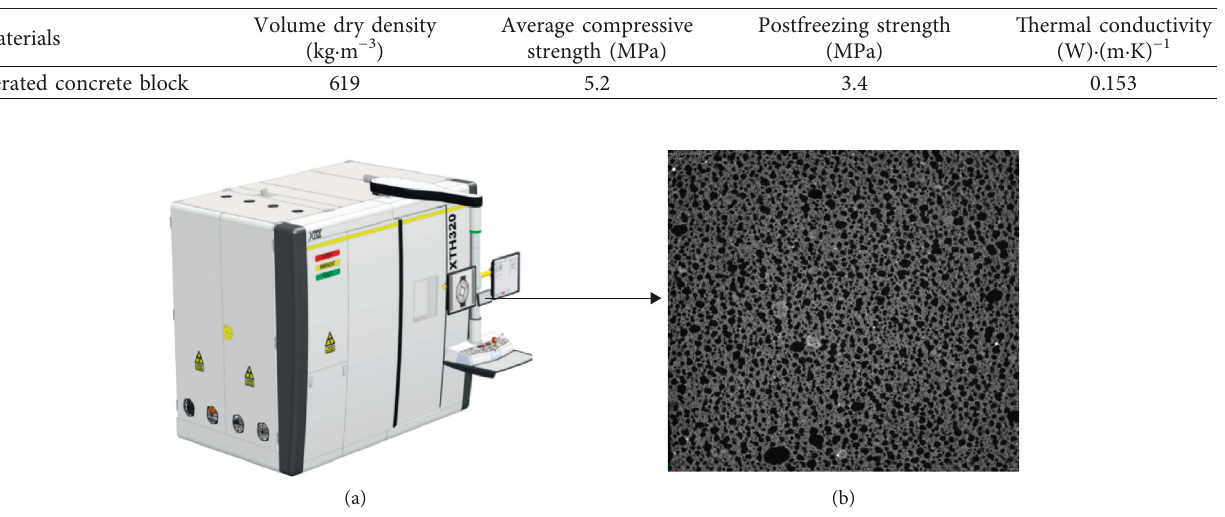
Table 1: Aerated concrete block-related performance parameters.